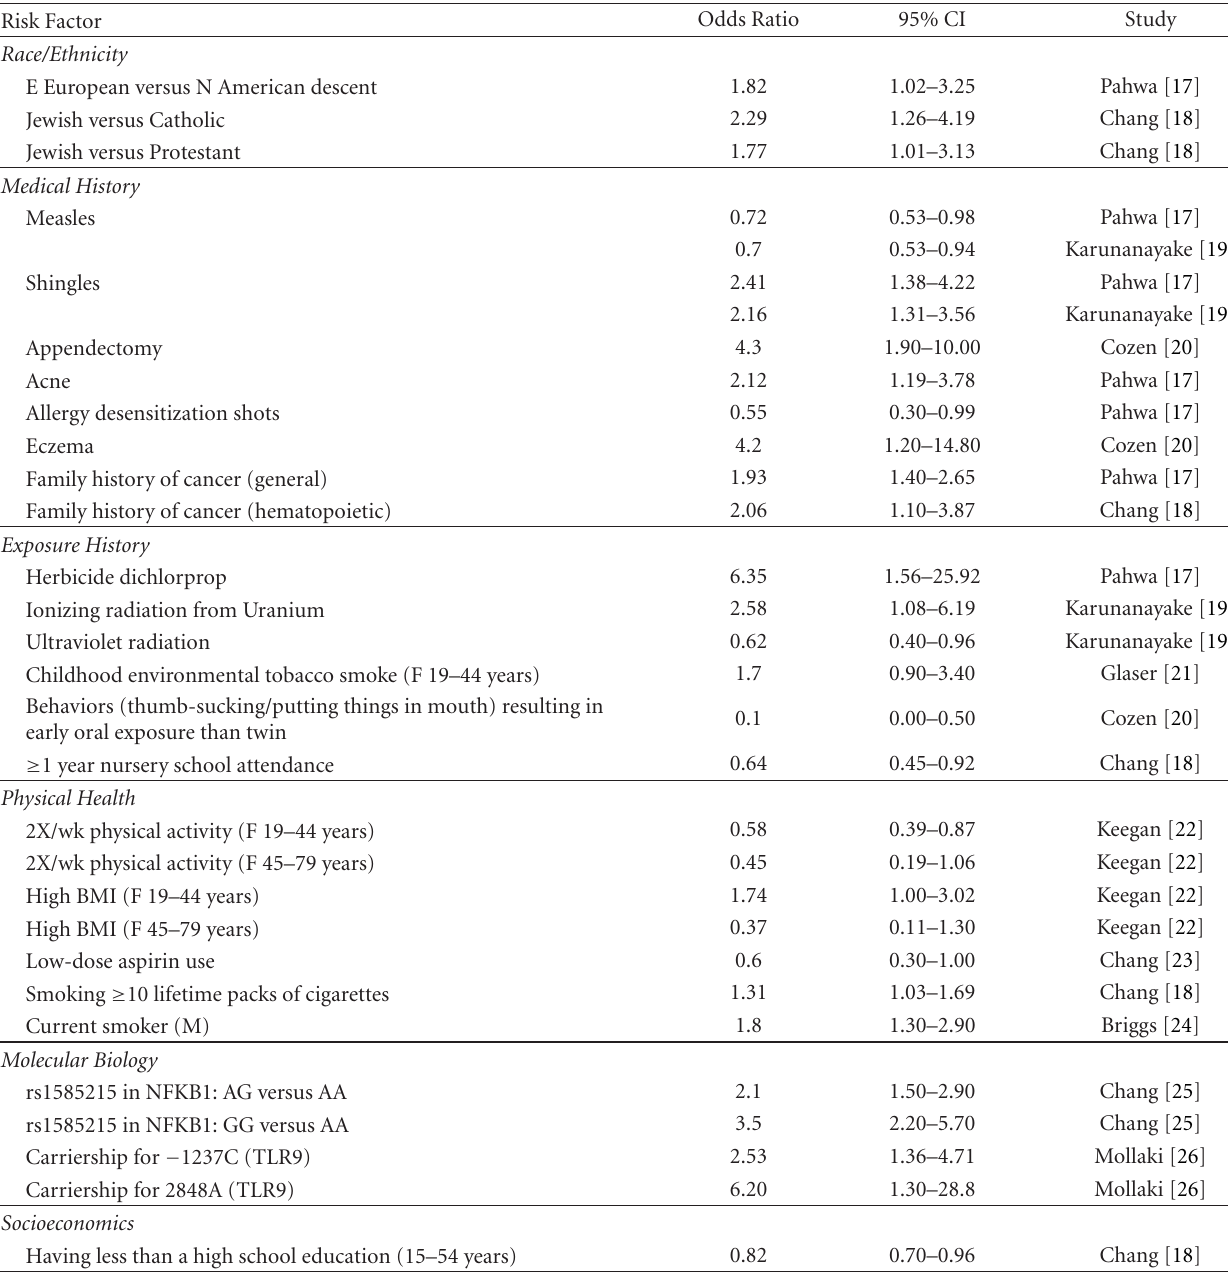
Table 1: Risk factors for Hodgkin